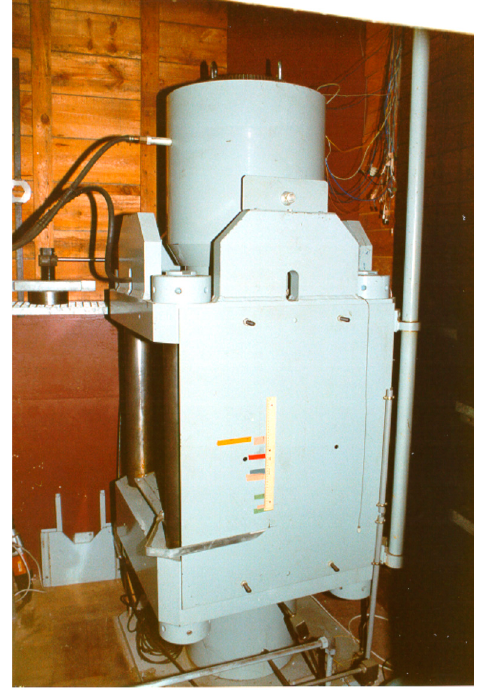
Figure 9. 2.5 GPa gas pressure vessel.